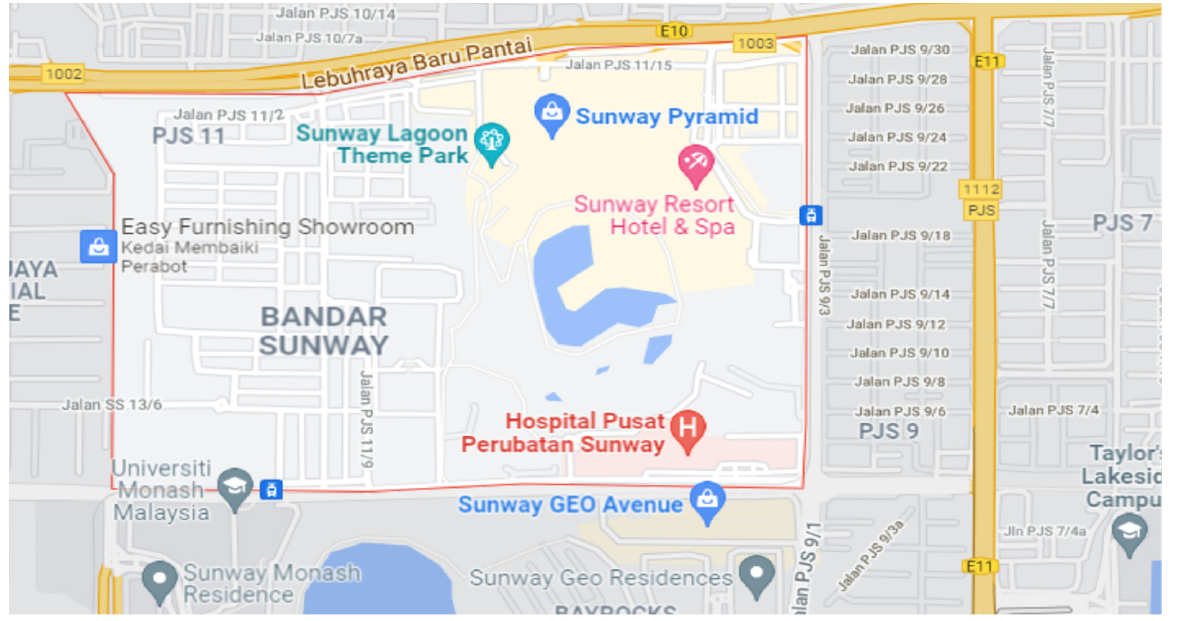
Figure 2. Targeted areas of the study (PJS7, PJS9, PJS 11). Source: [54].